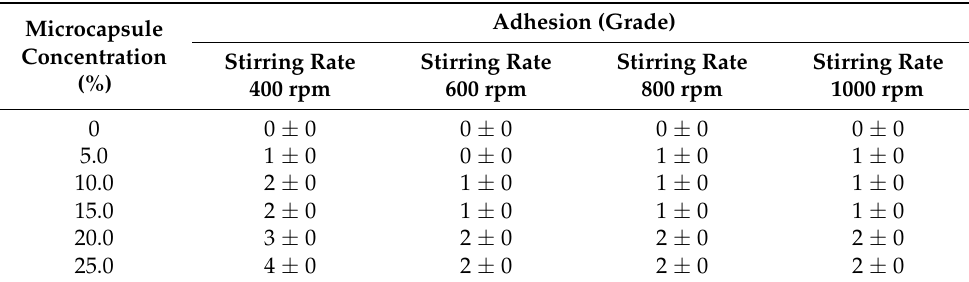
Table 3. Effect of microcapsule concentration with different stirring rates on adhesion of waterborne primer film.